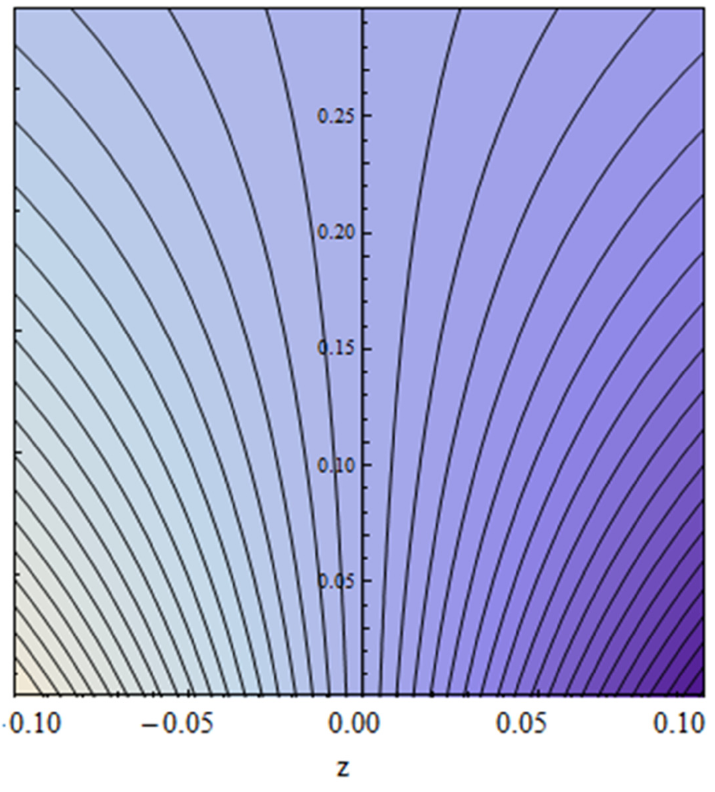
Figure 22. Streamlines impact at Br = 0.6 for Vogel’s model.